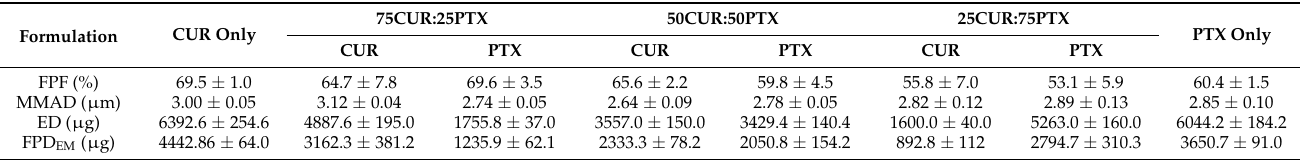
Table 2. FPF, MMAD, ED and FPD of DPI formulations of CUR and PTX using the RS01 HR device. Formulation